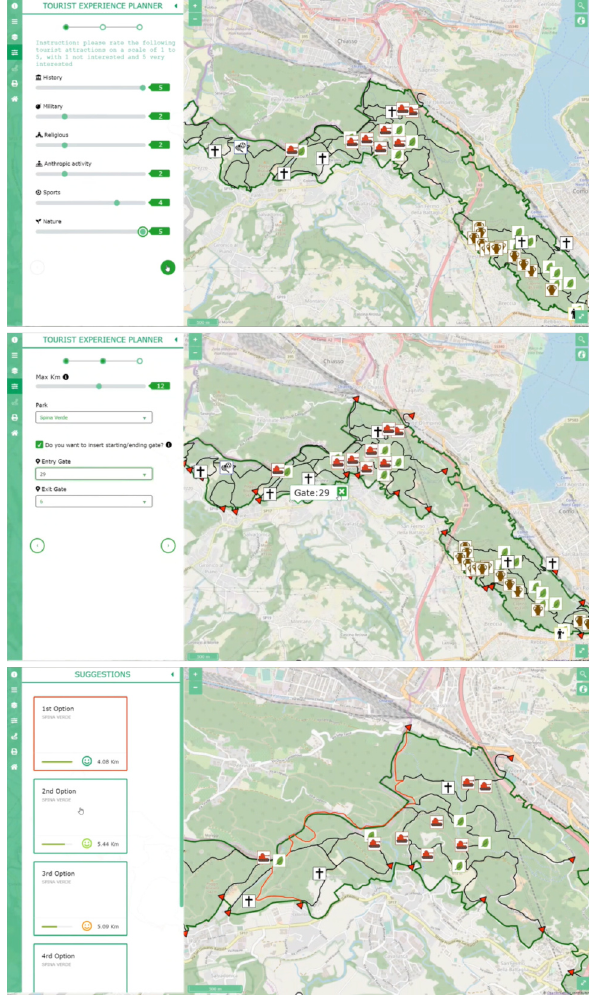
Figure 3. Prototype WebGIS application supporting the selection of the ºbest path to walkº using multi-criteria decision-making procedures.